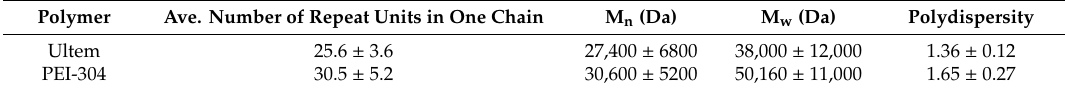
Table 3. Molecular mass of polyetherimides averaged over all samples.